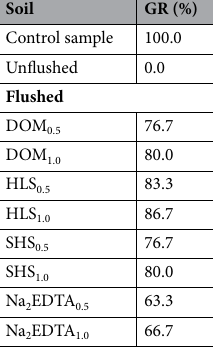
Table 3. Comparison of germination parameters in soil before and after flushing with DOM, HLS, SHS and Na 2